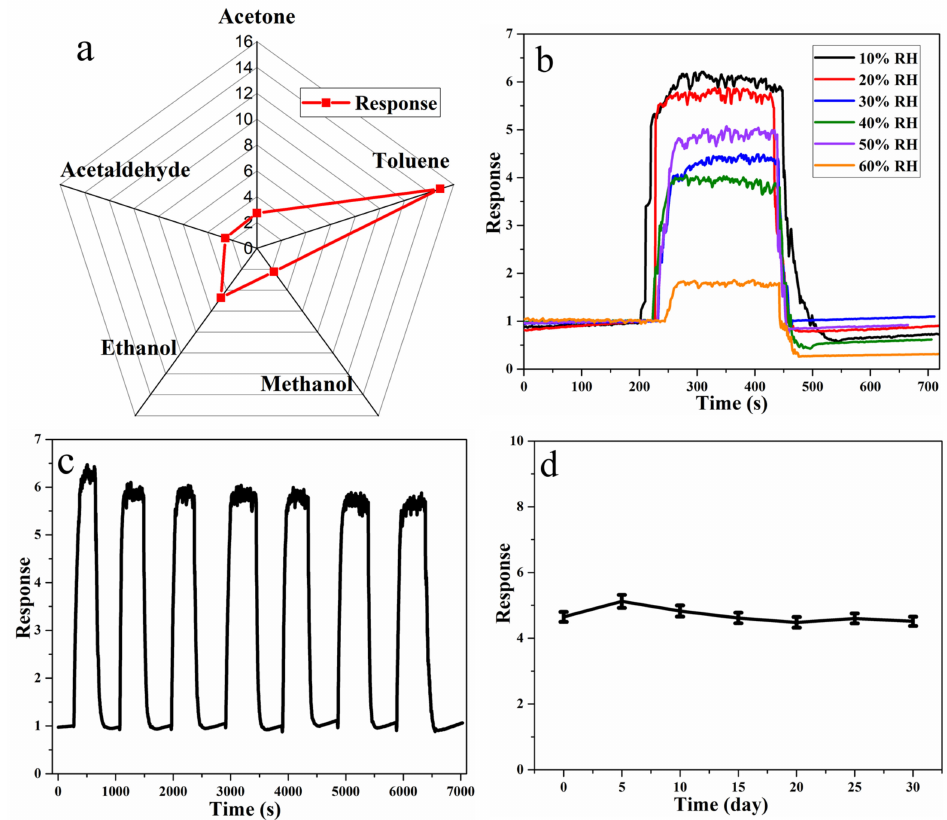
Figure 6. ( a ) Selectivity of five gases, ( b ) gas sensitivity test of toluene gas in different relative humidity (RH) environments, ( c ) repeatability and ( d ) long-term stability for toluene gas of TiO 2 − CoFe 2 O 4 − Ag at 263 ◦ C ( n =